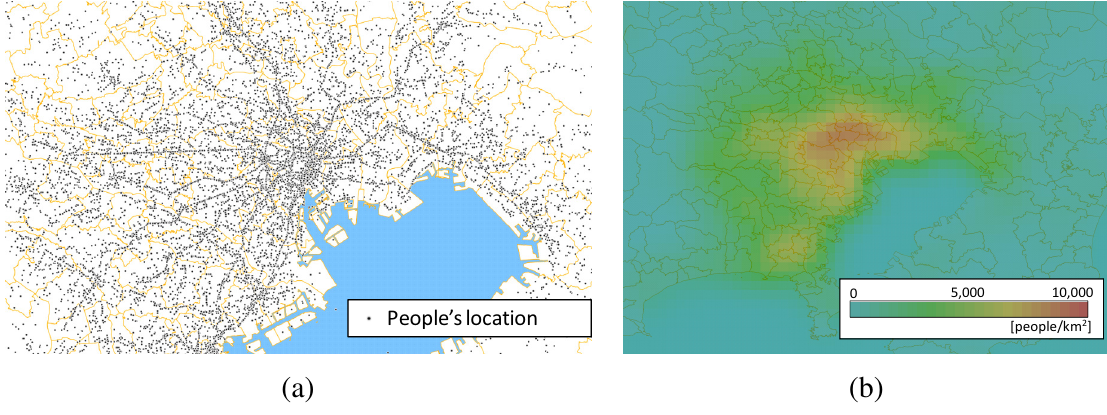
Figure 1. Two types of population visualization. ( a ) Moving points; ( b ) density distribution. Background map: